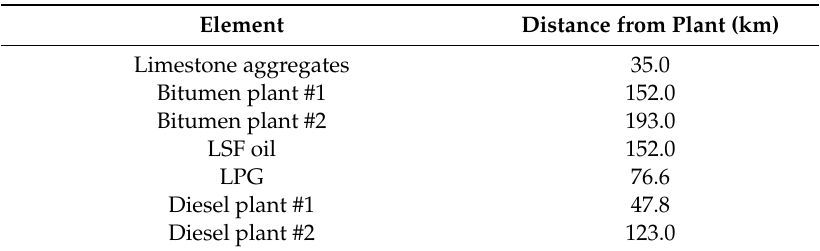
Table 2. Transportation distances for mixture components and